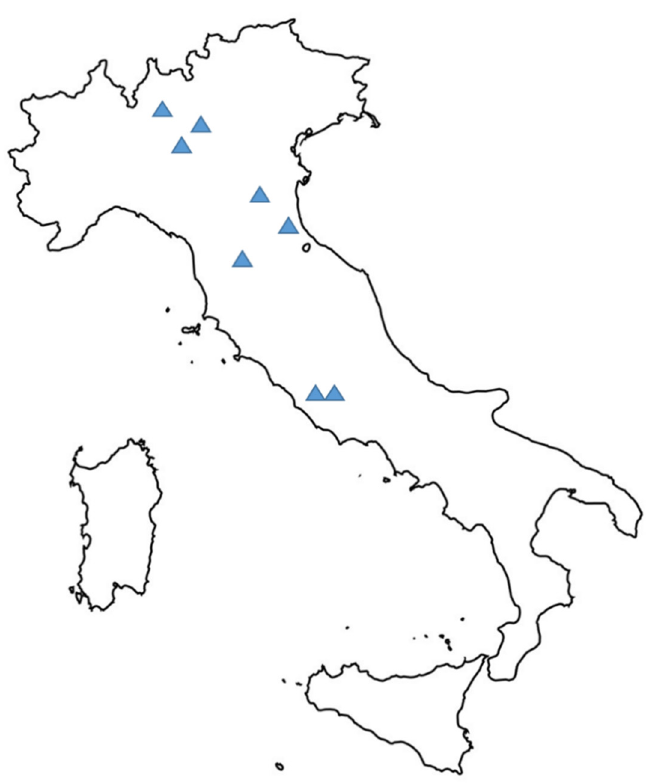
Figure 1. Geographical distribution of participating centers. The detailed list of the eight participating centers is available as supplementary material (Table S1).